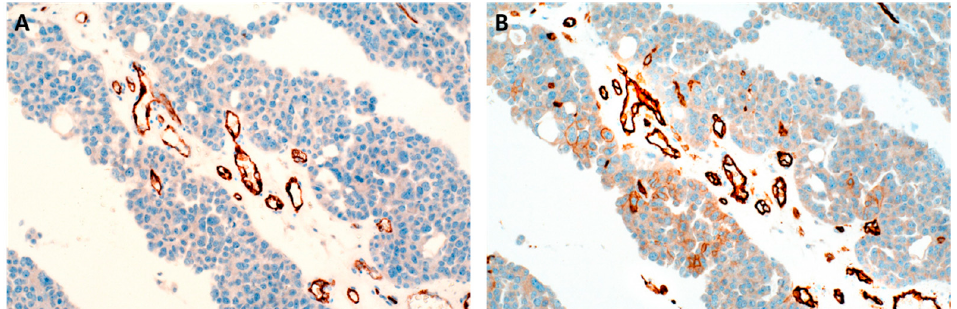
Figure 1. Representative immunohistochemical images of ovarian cancer samples. On the left, 90% tumor-associated vessels exhibit PSMA staining ( A ). On the right, vessels are delineated using a CD31 antibody ( B ); 20× magnification.